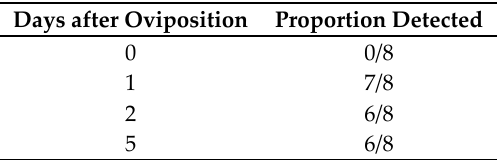
Table 6. Proportion of Tranosema rostrale eggs/larvae detected using the Module 1 assay, 0, 1, 2, and